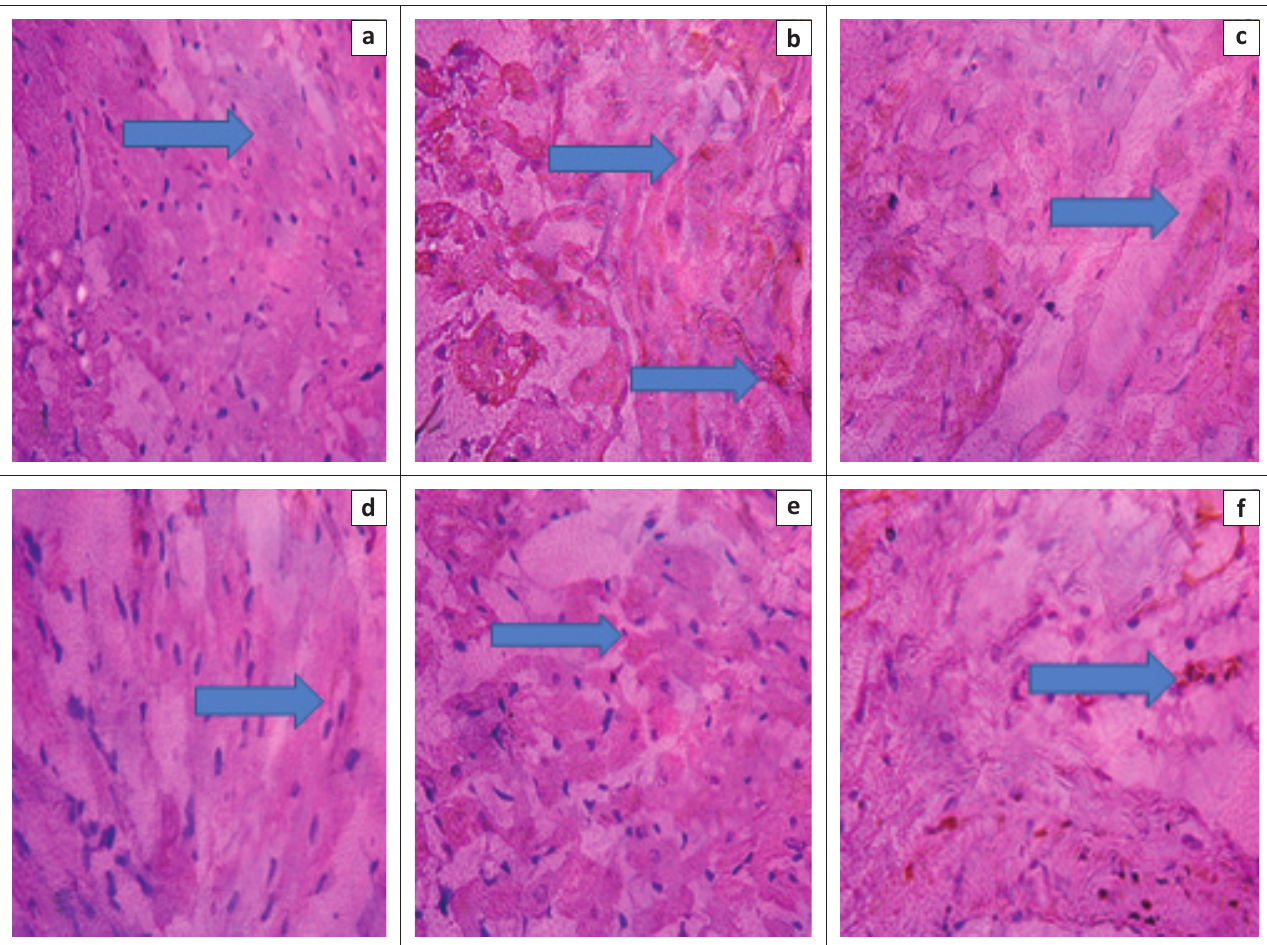
FIGURE 14: Immunohistochemistry of cardiac troponin in heart of isoproterenol-induced myocardial infarction rats. TABLE 2: Effects of the ethanolic leaf extract of Andrographis paniculata on ALT, AST and nitric oxide in isoproterenol-induced myocardial infarction in rats. Groupings Pre-treated groups Post-treated group Parameters